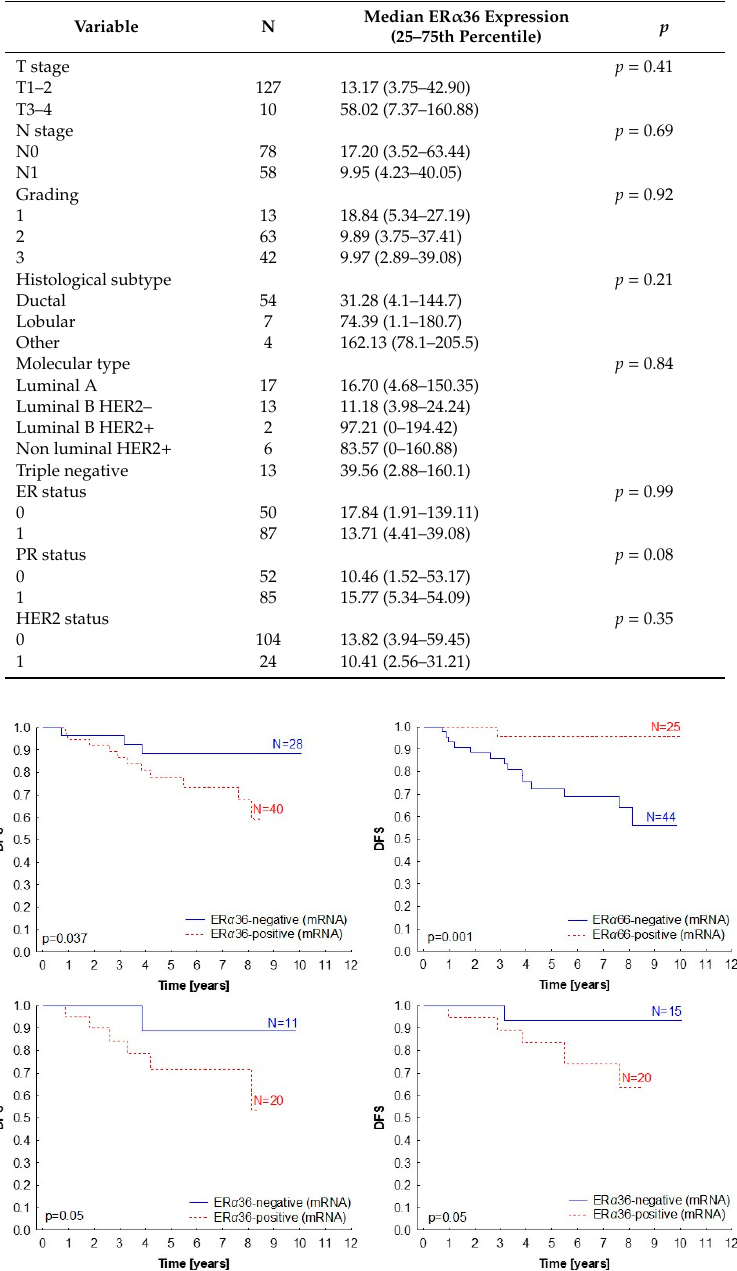
Table 2. Correlation between ER α 36 relative expression level (measured by qPCR) and the clinicopathological characteristics of the patients. HER2: human epidermal growth factor receptor 2. Variable N